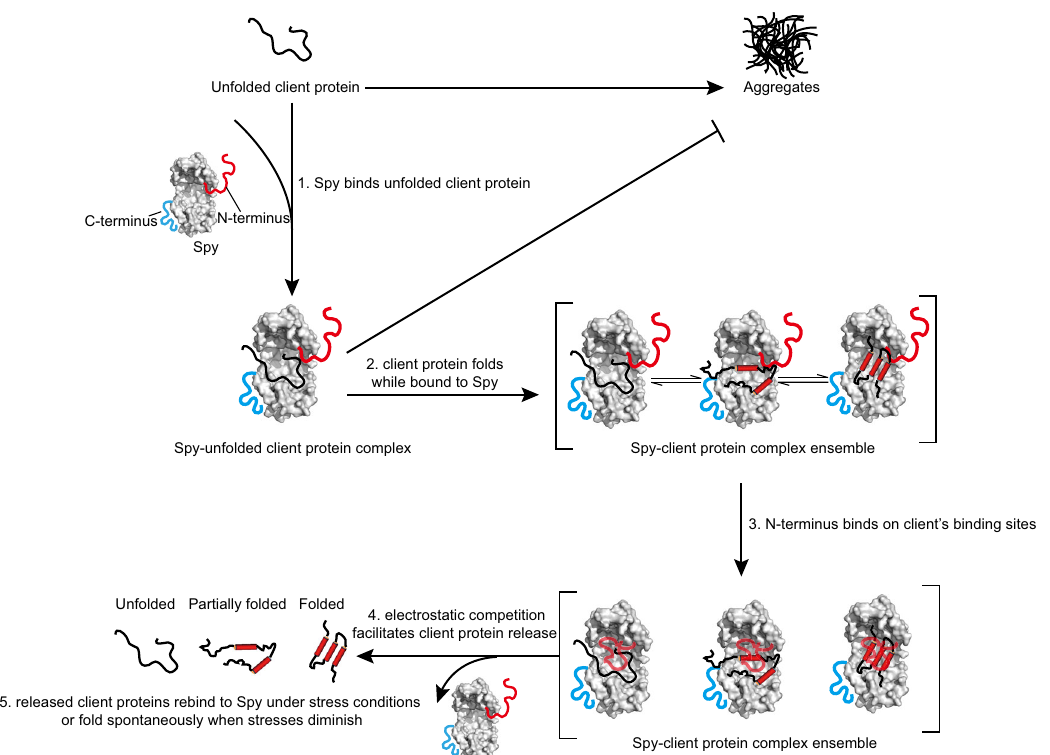
Fig. 7 Model for the auto-regulated chaperone mechanism of Spy. Spy binds unfolded or partially unfolded client proteins to suppress their aggregation. Client protein interconverts between different folding states by a previously proposed “ folding-while-bound ” mechanism 21 . The N terminus of Spy can competitively bind to Spy ’ s concave surface via electrostatic interactions. This process interferes with client retention and thus facilitates client protein release. Released client proteins can rebind to Spy under stress conditions or fold spontaneously when stress conditions diminish. For clarity, only one copy of the N and C termini are shown on the structure of the Spy